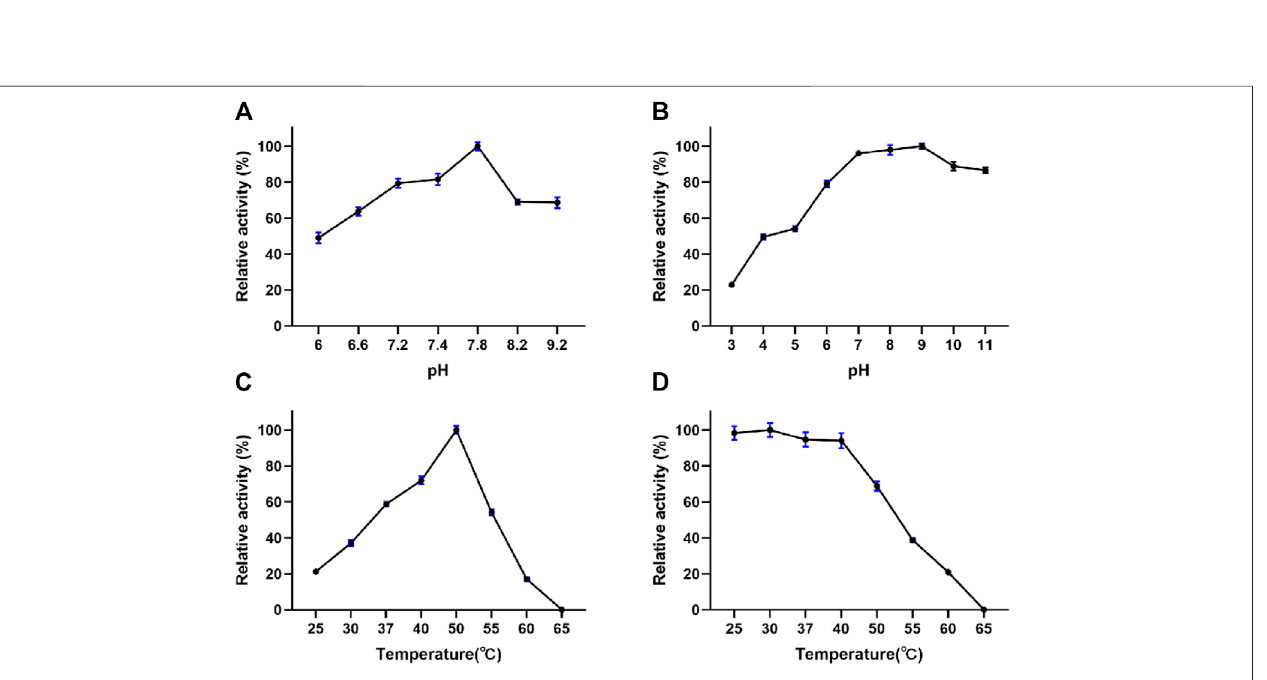
( Table 4 ). The fi brinolytic activity of EPF3 was absolutely inhibited by PMSF and SBTI, while TPCK, EDTA, Fe 2+ , and Cu 2+ showed partial inhibition. Pepstatin, Mg 2+ , and Ca 2+ did not show any inhibitory activity of EPF3. The results suggested that EPF3 might be a trypsin-like serine protease.